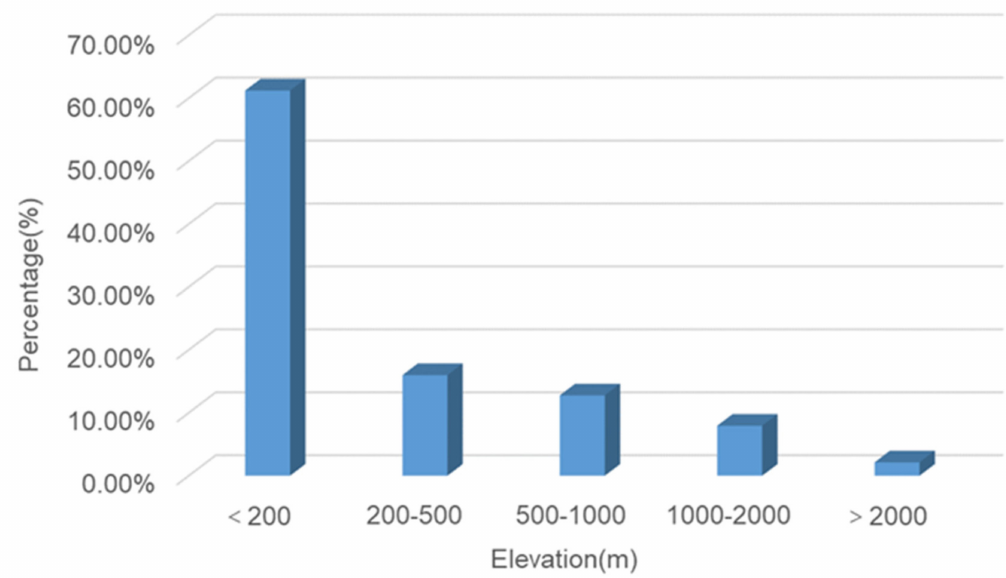
Figure 12. Area percentage of elevation grade relative to the study